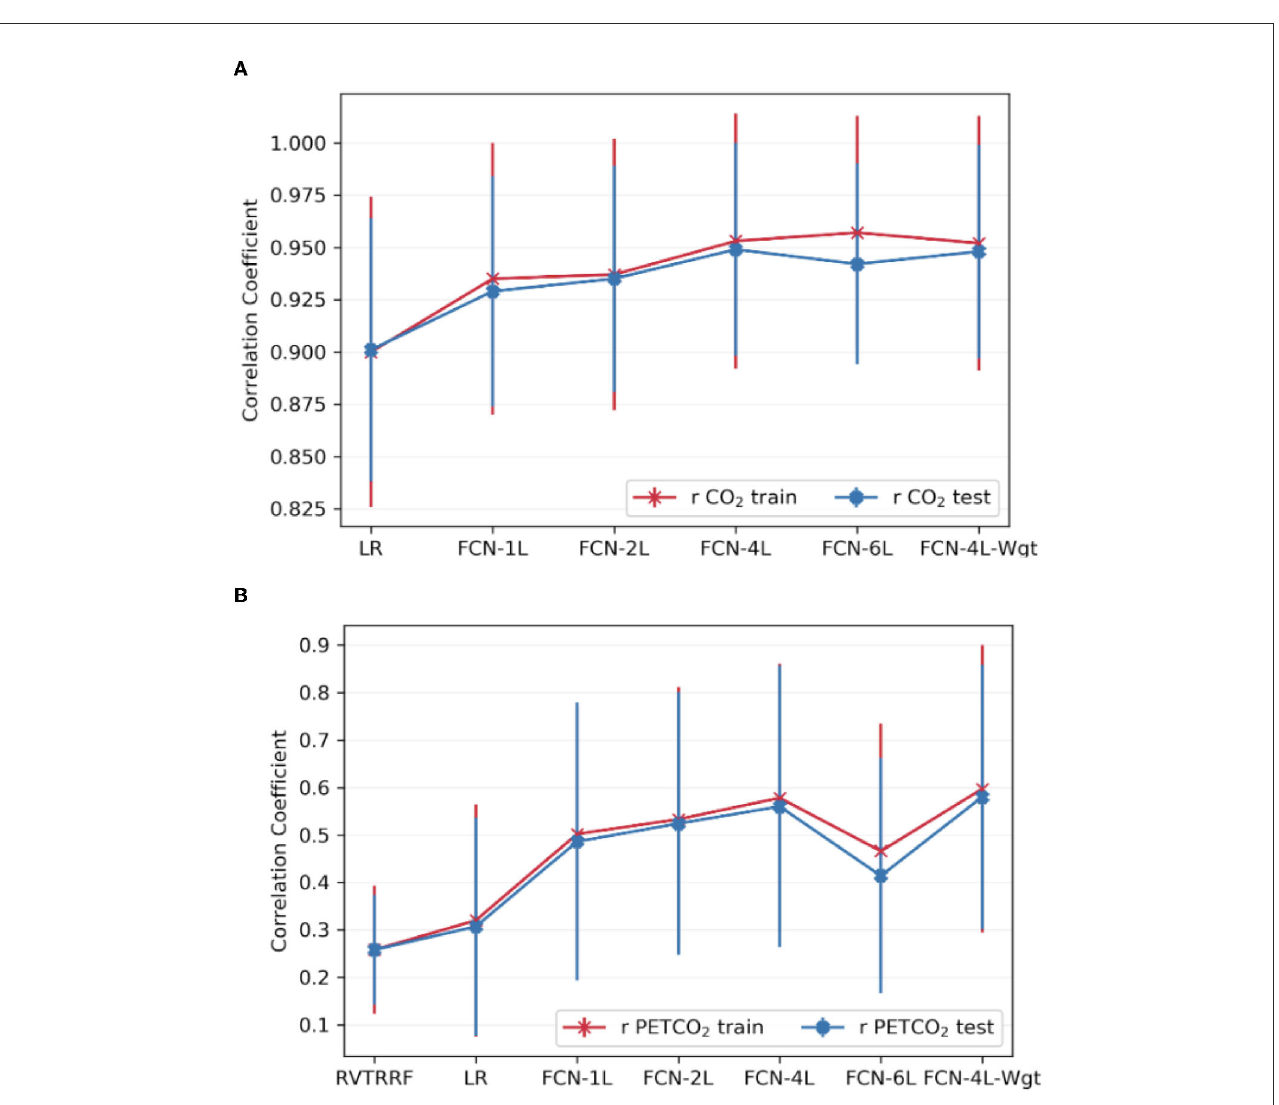
FIGURE6 Comparison of model performance on train vs. test datasets. The average Pearson correlation coefficient obtained across one of the splits for (A) CO 2 and (B) PETCO 2 between test and train dataset is shown in the top row. The error bars indicate the standard